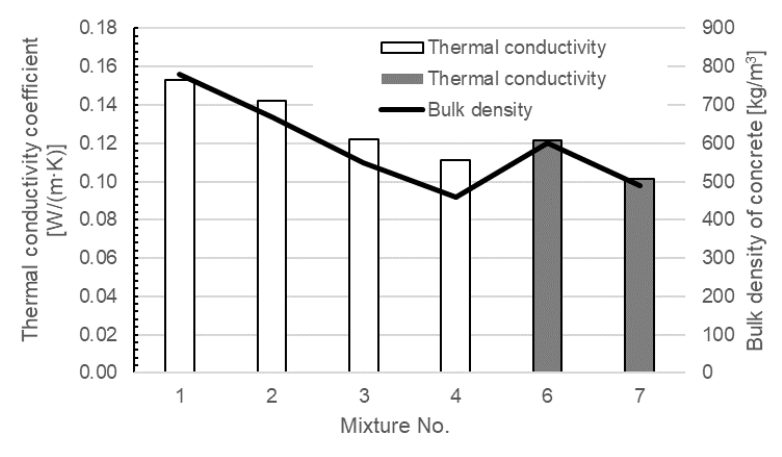
Figure 4. Thermal conductivity coefficient and bulk density of hardened lightweight concrete.